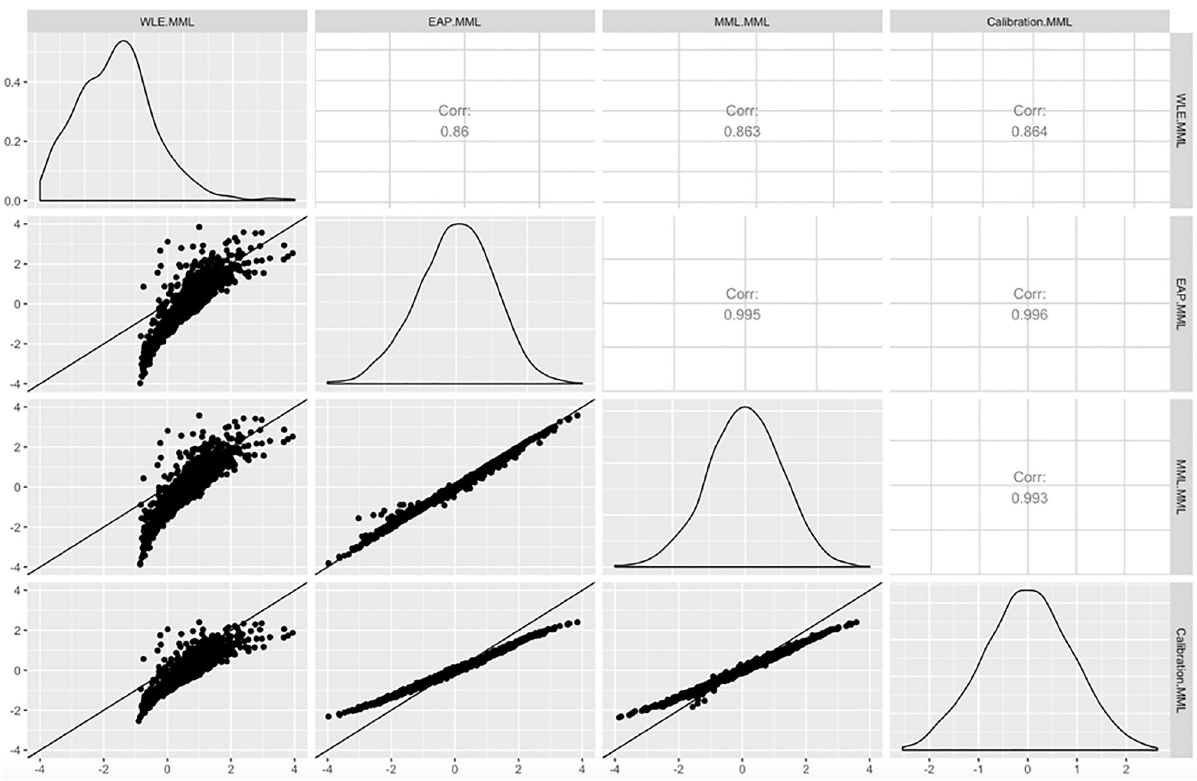
Fig 6. Pairwise comparison of scoring of the Basic Mobility (BM) scale calibrated using marginal maximum likelihood (MML). The methods compared are Warm’s weighted likelihood estimator (WLE), EAP, and MML. Calibration MML refers to the score inferred during item calibration.